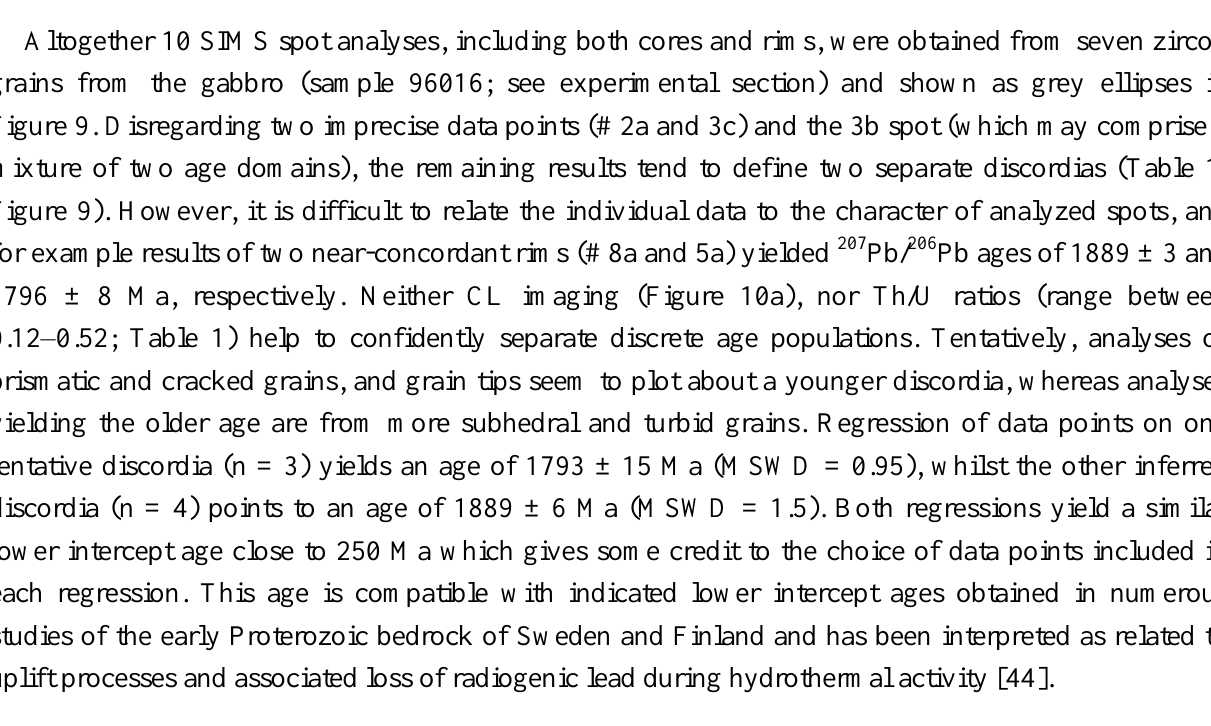
Figure 9. U-Pb concordia diagrams with analytical results for baddeleyite; bd (black symbols in inset, TIMS data) and zircon (grey symbols, SIMS data) separated from the gabbro. For the sake of clarity, the two most discordant zircon data points and one analysis with a large error are